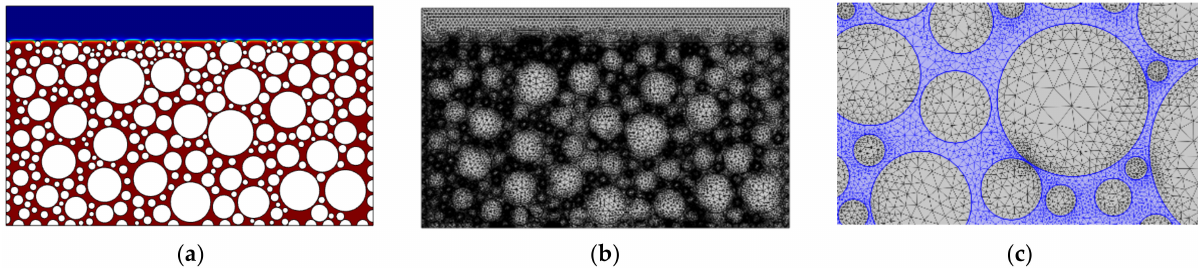
Figure 2. Ideal inhomogeneous rock model. ( a ) Initial oil and water distribution (blue area represents water and red area represents oil). ( b ) Triangular meshing. ( c ) Amplified local grids.